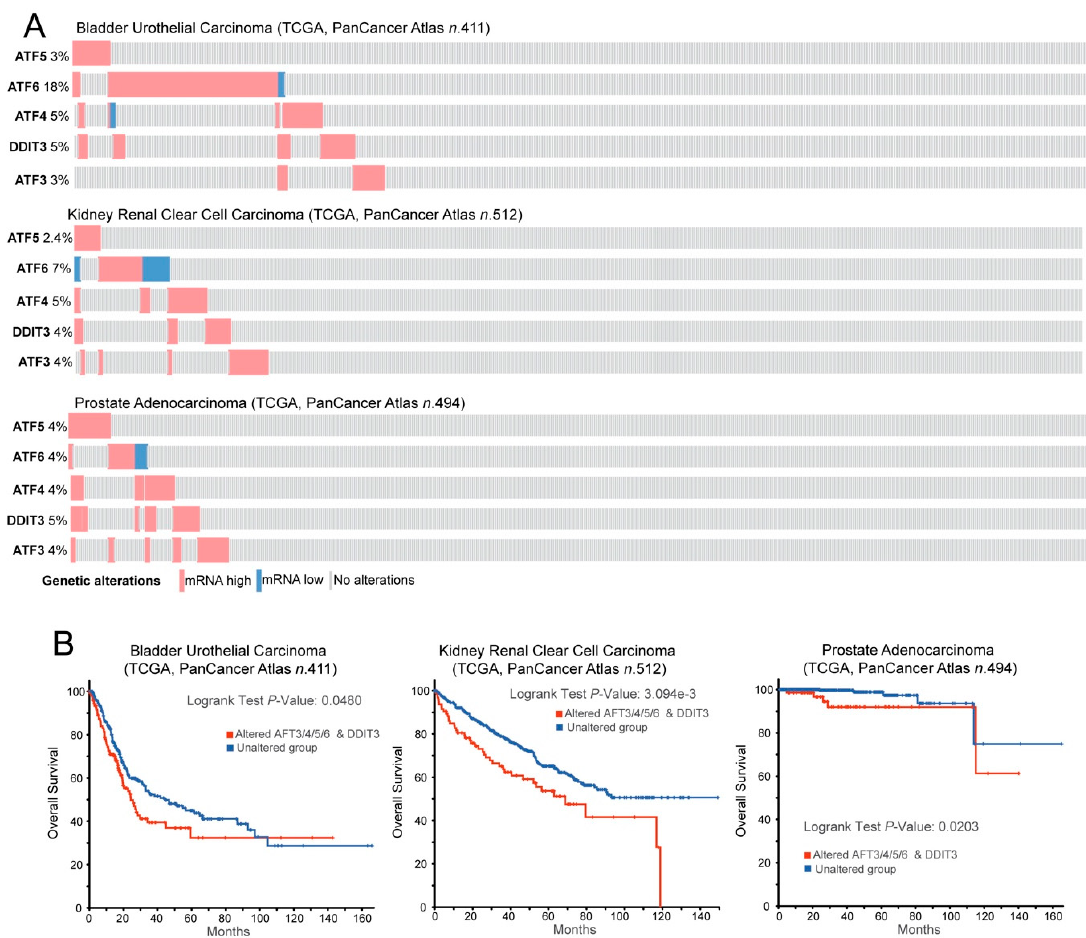
Figure 3. ATF factors in cancer. ( A ) Oncoprint of mRNA expression variations for the indicated TFs. Data were obtained from the TCGA database and include RNAseq data from patients, as indicated.